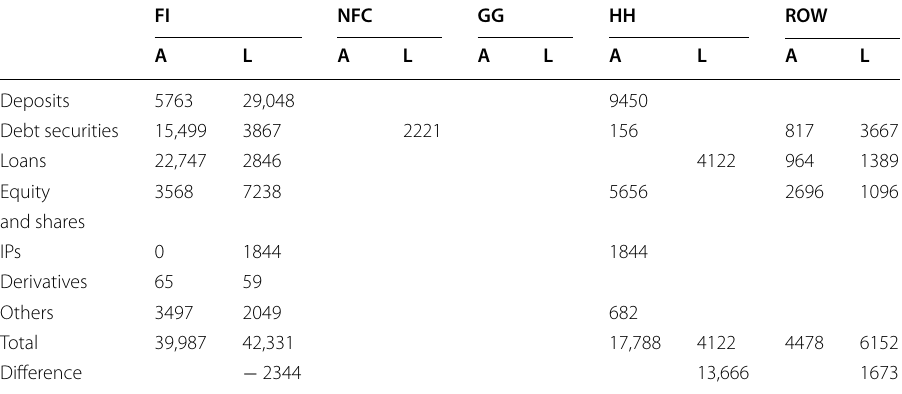
Table 9 Estimation of China’s HH, ROW and FI Sectors and debt securities (in units of 1 billion USD)